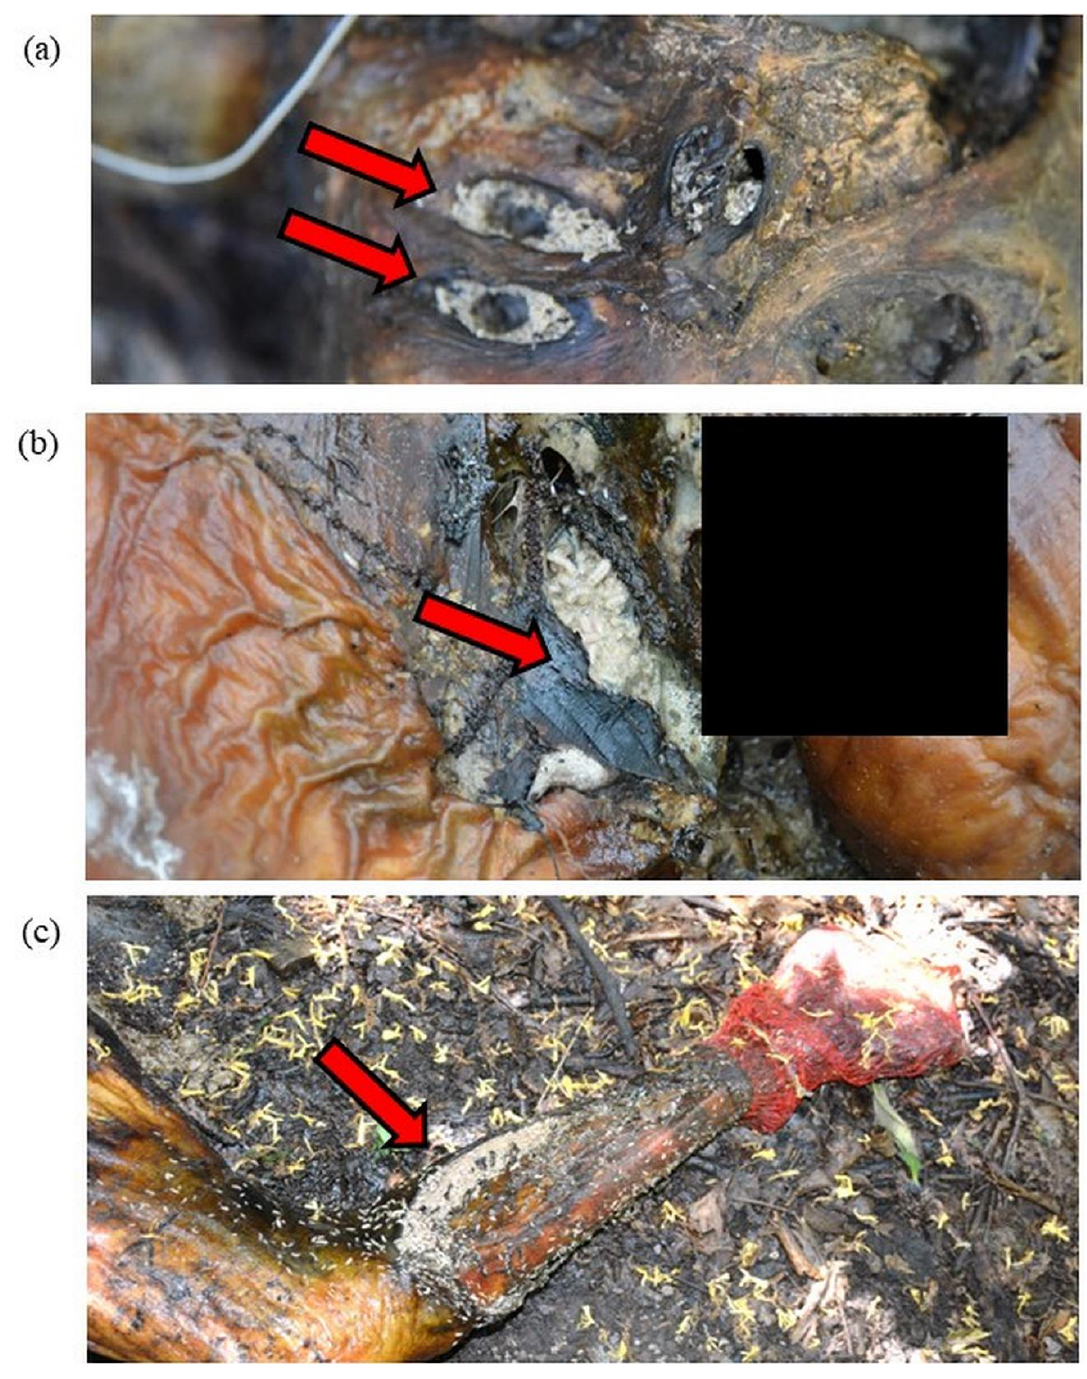
Figure 1. Blow fly larvae collected from each donor. ( a ) Donor 1 on the first day of larval sampling after first observation of colonization, 115 d (236.0 ADD) post-placement. Red arrows indicate larval aggregations in the eye and face. ( b ) Donor 2 on the last day of larval sampling, 280 d (1,024.8 ADD) post-placement. Red arrow indicates larval aggregation at the groin. ( c ) Donor 3, 53 d (266.9 ADD) post-placement. Red arrow indicates larval aggregation on the right calf. Table 2. Summary of third instar larval Phormia regina sampled on the first collection day from Do- nor 1 and from the last collections days for Donors 2 and 3. The total exposure time from placement to the sampling of third instar P. regina is given in days (d) for each donor. The 15 °C dataset from the Byrd and Allen (2001) developmental study was used to determine the time of colonization (TOC) estimation range. Temperature = mean ± standard deviation for exposure period given in °C. Site = larval sampling location on or around each donor (GBI = ground-body interface). TOP is given